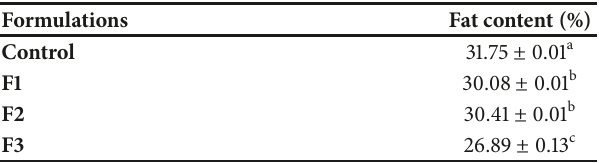
Table 5: Fat content (%) for the snacks obtained with different formulations ∗